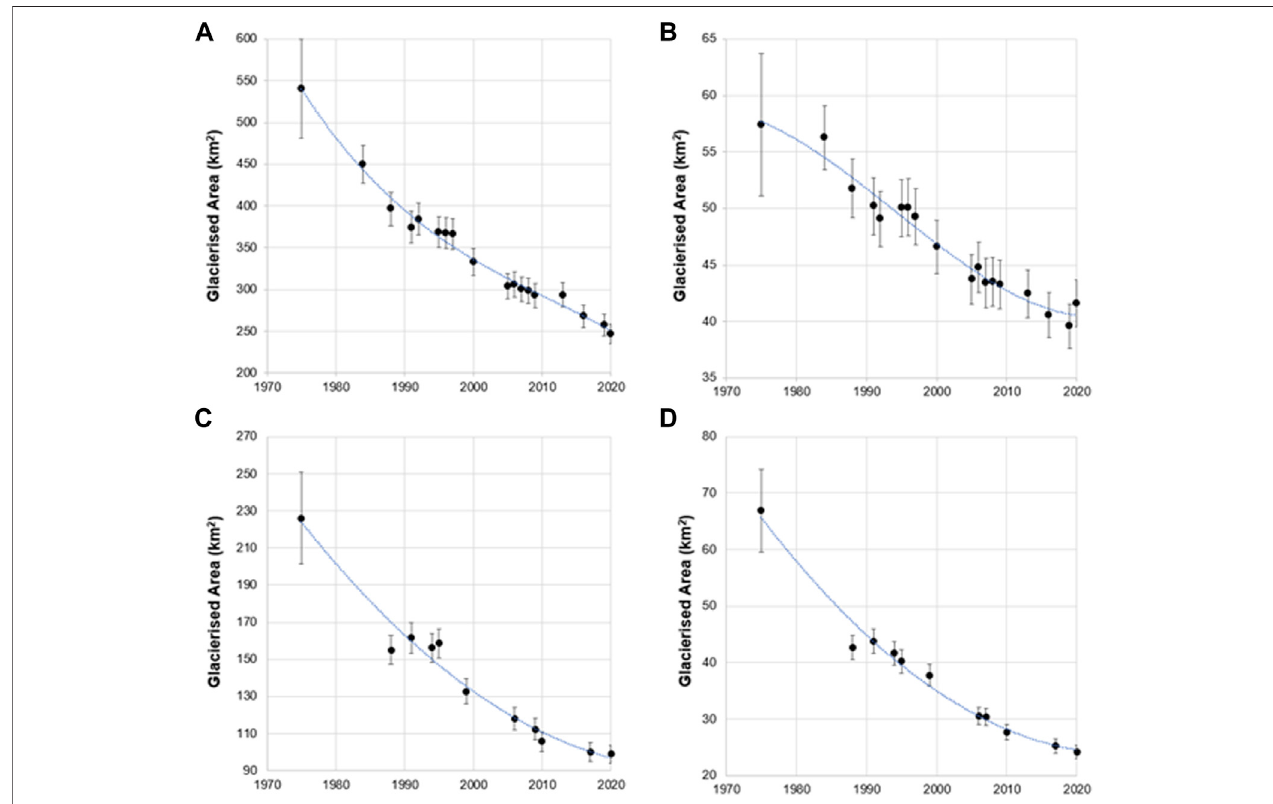
FIGURE 2 | Glacierised Area of (A) Cordillera Vilcanota, (B) Quelccaya ice cap, (C) Cordillera Vilcabamba, and (D) Cordillera Urubamba. Note the varying y -axis scales. Blue line represents second-order polynomial fi t.